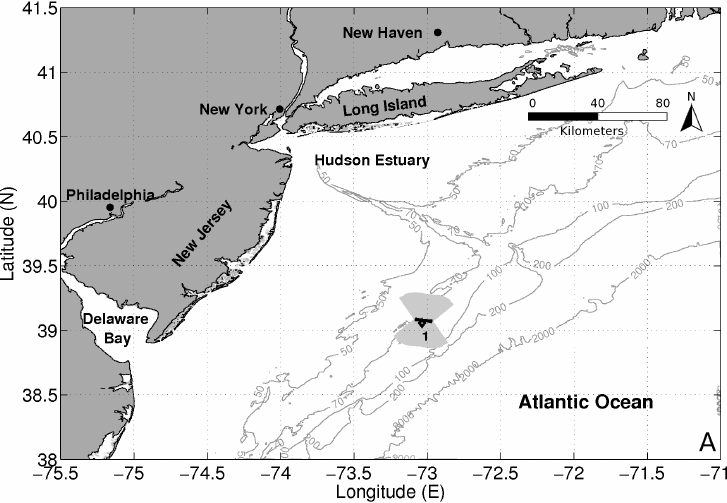
Figure A.1. Bathymetric map of ( A ) New Jersey continental shelf and ( B ) Georges Bank showing the location of the fan-shaped patches used for estimating the magnitude squared of the Rayleigh–Born seafloor scattering amplitude. The seafloor scattered field data from these patches was collected along several tracks (black lines) for the respective OAWRS source locations (black diamond) during the (A) 2003 OAWRS experiment for source location 1 (39.0563 ◦ N, − 73.0365 ◦ E) and two receiver tracks extended between (39.08 ◦ N, − 73.08 ◦ E) and (39.07 ◦ N, − 72.97 ◦ E); and (39.09 ◦ N, − 73.08 ◦ E) and (39.06 ◦ N, − 72.97 ◦ E); and (B) 2006 OAWRS experiment for source location 1 (41.8901 ◦ N, − 68.2134 ◦ E), source location 2 (41.9372 ◦ N, − 68.1046 ◦ E), and source location 3 (42.0134 ◦ N, − 67.829 ◦ E) and respective receiver tracks extended between (41.83 ◦ N, − 68.35 ◦ E) and (41.81 ◦ N, − 68.32 ◦ E); (41.98 ◦ N, − 68.2 ◦ E) and (42.05 ◦ N, − 68.0 ◦ E); and (42.05 ◦ N, − 67.85 ◦ E) and (42.1 ◦ N, − 67.89 ◦ E). The gray lines represent depth